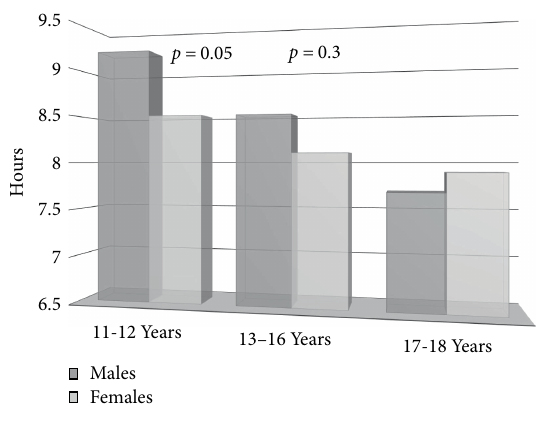
Figure 1: Sleep time by gender & age group.